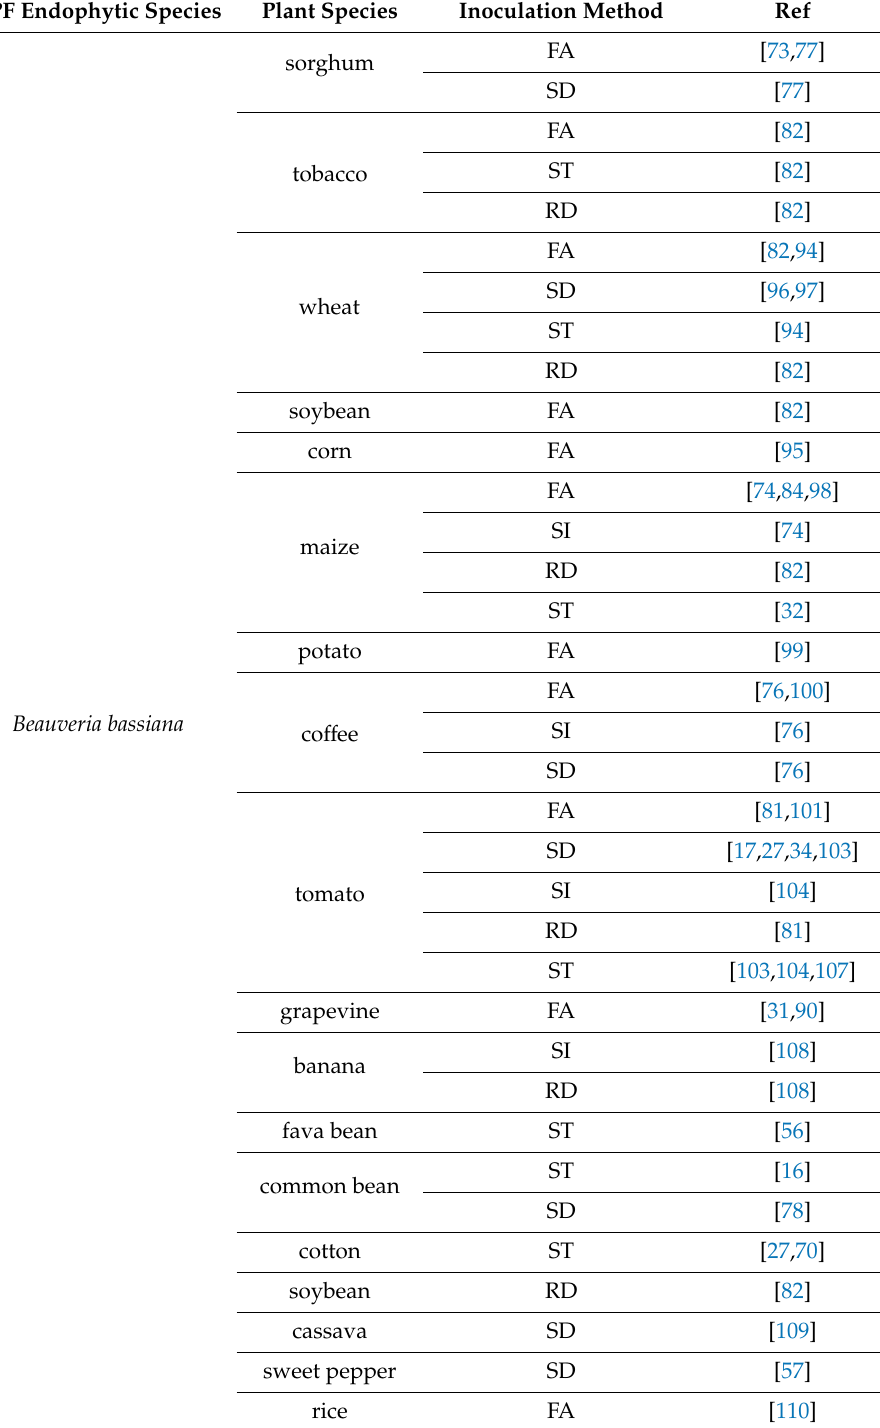
Table A1. Successful cases of artificial plant inoculation with endophytic EPF in major crop